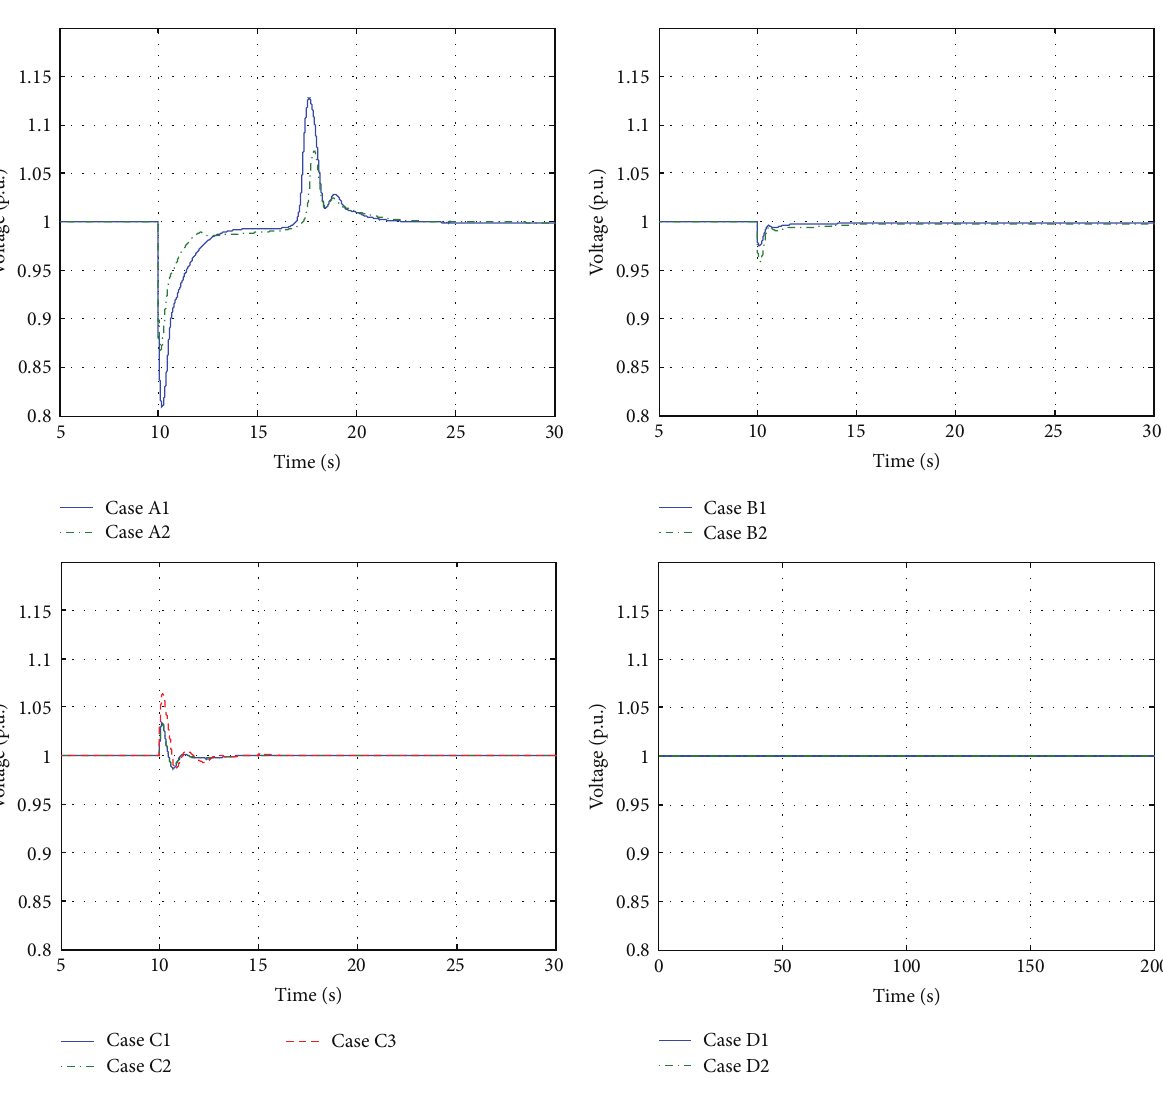
Figure 8: Voltage variations under transient conditions for the 9 simulation cases.